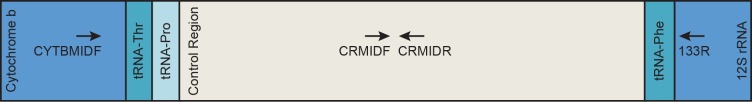
Relative position of primers used in DNA amplification and sequencing of the complete orang-utan mitochondrial DNA control region.The sizes of each region in this schematic are proportional to their sizes in the orang-utan mitochondrial genome.